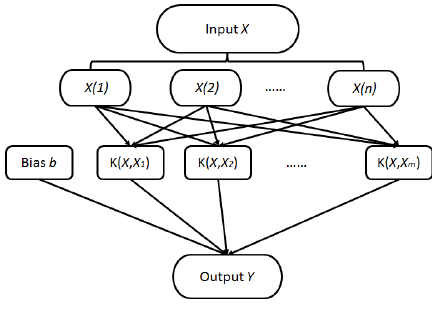
Figure 1. Main structure of a support vector machine (SVM) [35].